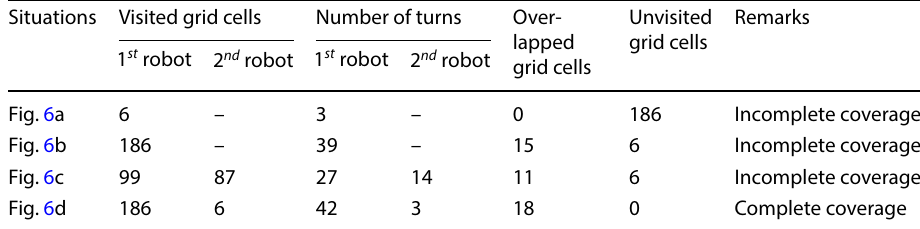
Table 3 Failure and completion of complete grid coverage in an environment consisting of free space enclosed by obstacles